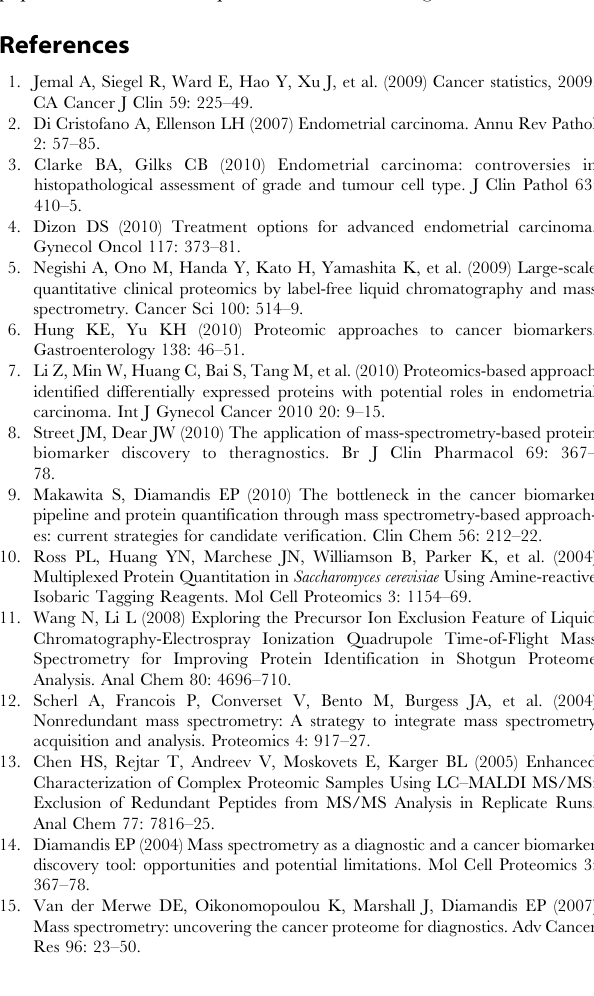
Proteins identified by a single peptide were sorted on top of the table. # Occurences = number of times a particular peptide has been identified over all sample sets. At the bottom of this table, summary of the number of peptides per proteins. B - Identified peptides whose Proteinpilot confidence was greater than 99%. Table S4 Samples in which each protein from Table 2 has been